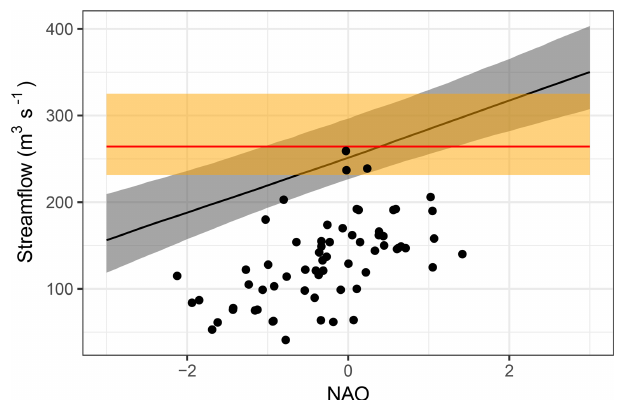
Figure 8. Comparison of climate-informed and classical streamflow quantiles for station A (see Fig. 7 and Tables 5 and 6 for more de- tails), an exceedance probability of 0.02 and NAO as covariate of the climate-informed model. The legend is the same as in Fig. 7. Observed streamflow is indicated with black